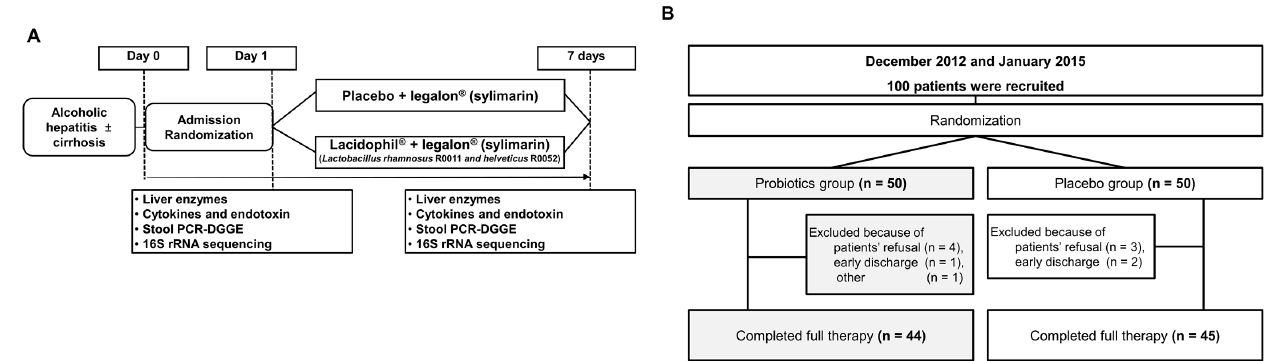
Figure 1. Study design and flow chart. ( A ) Schematic flow chart design of the study. ( B ) Randomi- zation and allotment of the patients.